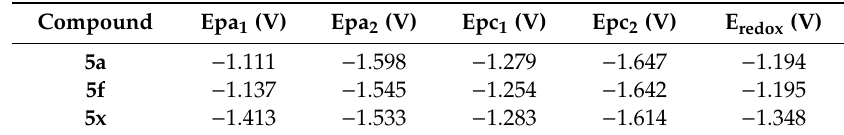
Table 3. The major electrochemical parameters of selected naphthoquinones (c = 1 mmol/L), using CV